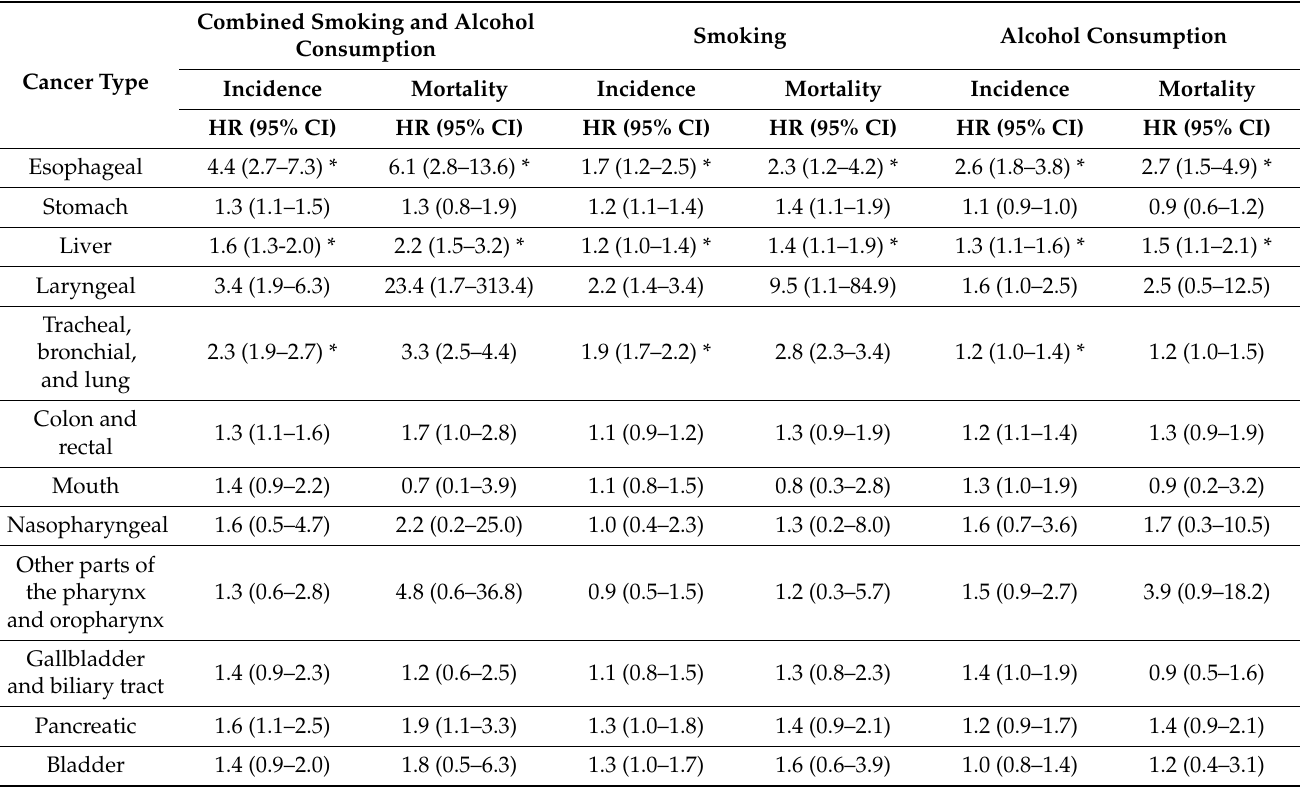
Table 2. Cancer type-specific incidence and mortality rates stratified by smoking and alcohol con- sumption in Korean